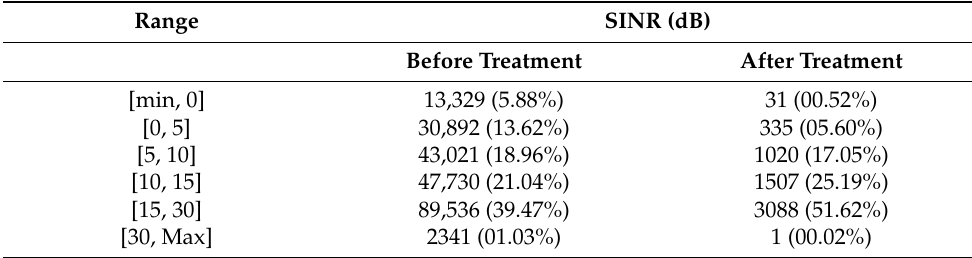
Table 3. SINR values before and after